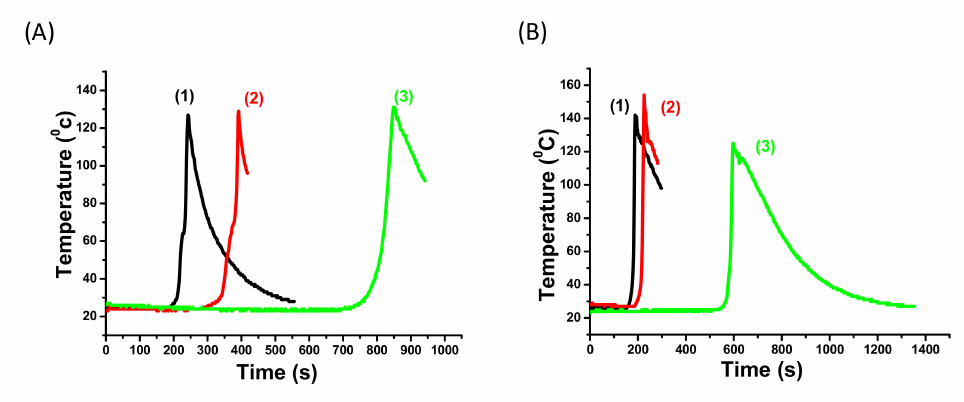
Figure 1. Optical pyrometric measurements (temperature vs. time after mixing; 4 mm thick sample) under air in resin 1 for Redox FRP for ( A ): (1) Cu(AAEMA) 2 / DPS (0.5 / 2 %wt), (2) Cu(AAEMA) 2 / DPS (1 / 1 %wt), (3) Cu(AAEMA) 2 / DPS (2 / 0.5 %wt) and ( B ): (1) Mn(acac) 2 / DPS (0.5 / 2 %wt), (2) Mn(acac) 2 / DPS (1 / 1 %wt), (3) Mn(acac) 2 / DPS (2 / 0.5 %wt) initiating systems. 4-N,N-trimethylaniline (4-N,N-TMA), a benchmark amine used as reduction agent, does not show